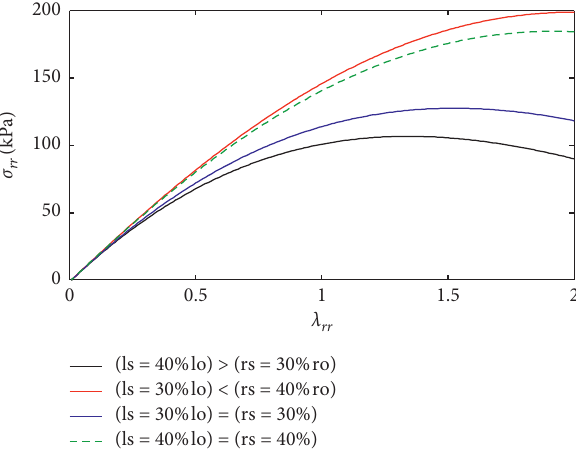
Figure 6: Comparative study of the deposition of plaque on radial